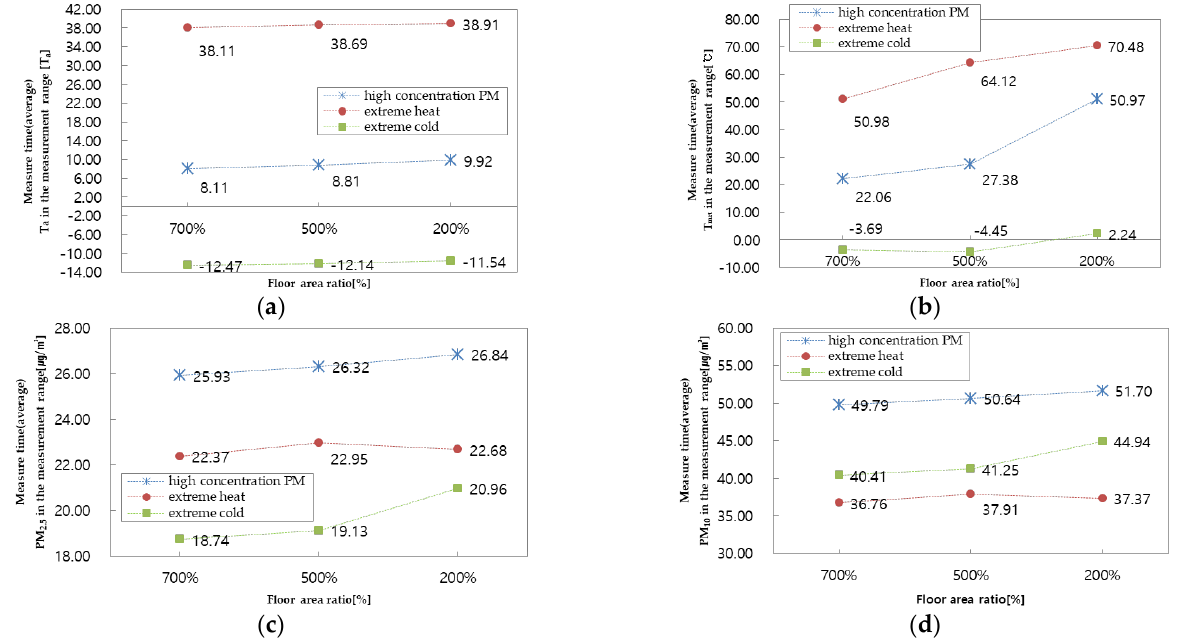
Figure 5. Correlations between floor area ratio and PM (PM 2.5 , PM 10 ) and microclimate (T a , T mrt ) elements: ( a ) T a within the measurement range based on the change in floor area ratio; ( b ) T mrt within the measurement range based on the change in floor area ratio; ( c ) PM 2.5 within the measurement range based on the change in floor area ratio; ( d ) PM 10 within the measurement range based on the change in floor area ratio.